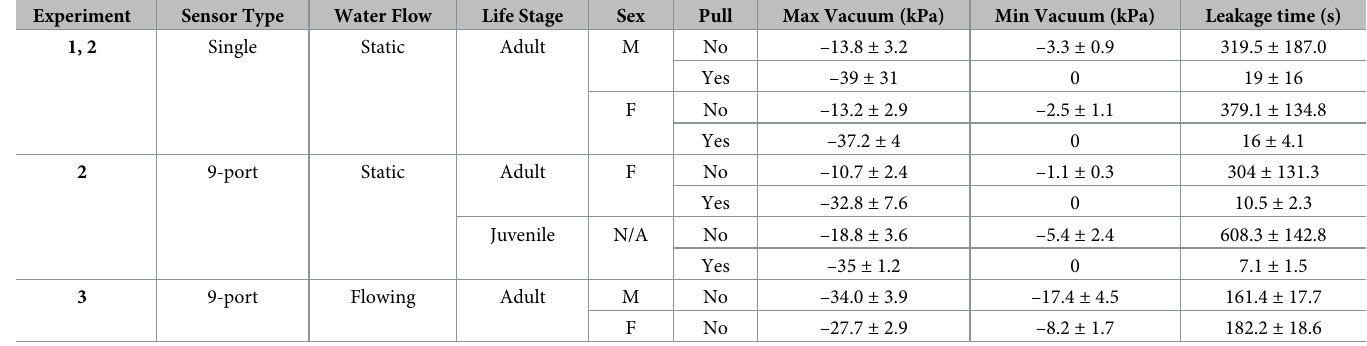
Table 2. Statistics of the pressure measurement results corresponding to Table 1, including manual pull condition (pull), maximum suction pressure before dis- engagement (max vacuum), minimum suction pressure to remain attachment (min vacuum), and the duration period between two adjacent pressurizing processes (leakage